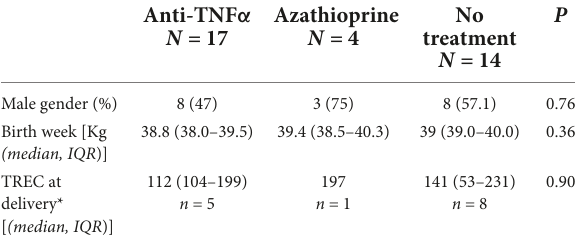
TABLE 4 TREC number at delivery of infants exposed in utero to anti-TNF alpha or azathioprine compared to unexposed infants of mother with IBD.